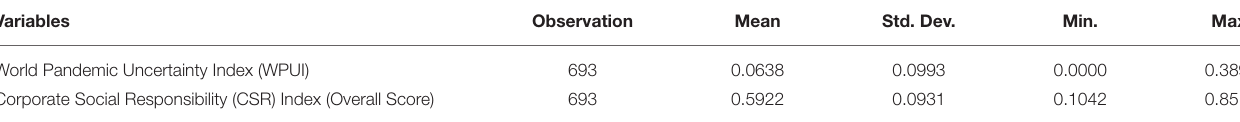
TABLE 1 | Description of summary statistics.